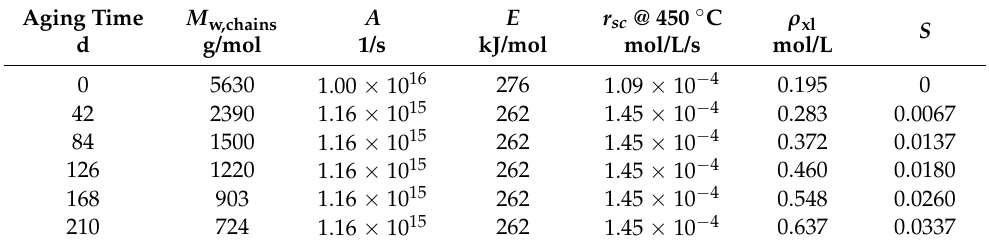
Table 1. Results of fitting the theoretical model to the experimental TGA data.